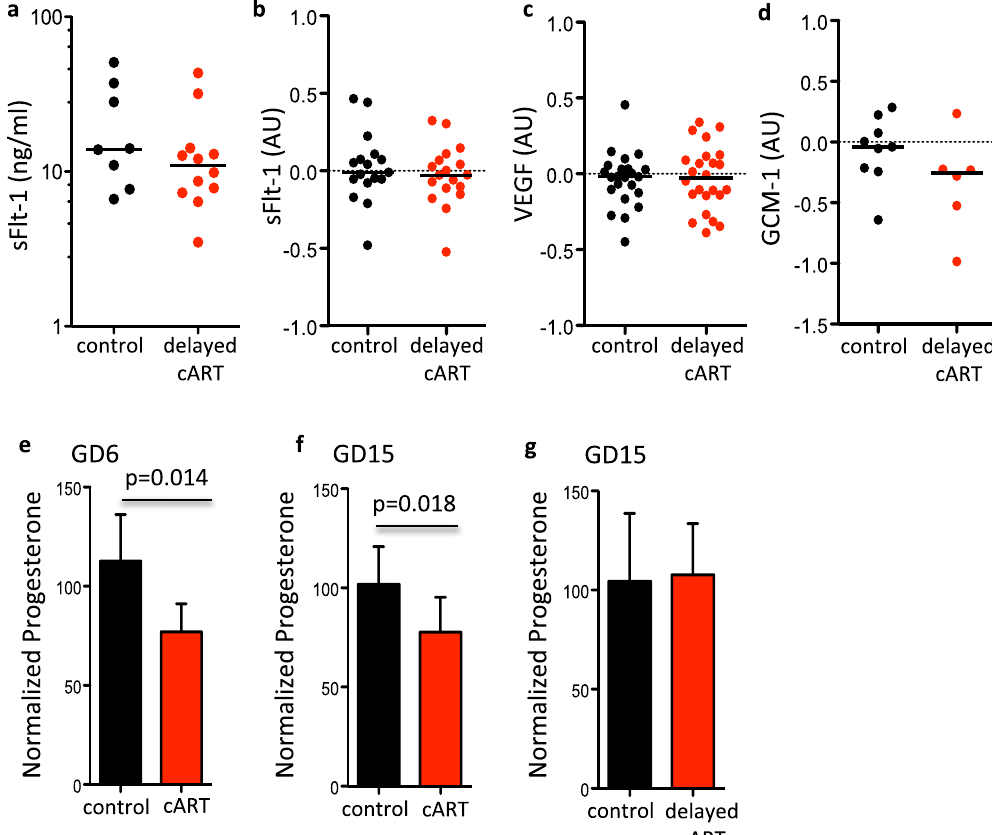
Figure 4. Delaying initiation of cART prevents dysregulation of sFlt-1 and Gcm-1, and progesterone declines. Pregnant mice were treated by gavage with cART (zidovudine/lamivudine/lopinavir/ritonavir) or water as a control starting on GD6 (delayed cART) until sacrifice on GD15. Peripheral levels of sFlt-1 ( a ) were assessed by EIA in serum collected at GD15 from control (black, n = 8) and cART-treated (red, n = 12) pregnant mice. Placental expression levels (log transformed) of sFlt-1 ( b ), Vegf ( c ), and Gcm-1 ( d ) were assessed by qPCR in placentas from control (black) and cART-treated (red) mice collected at GD15. For ( b ) n = 17 placentas from 7 dams for control and n = 18 placentas from 9 dams for cART, for ( c ) n = 23 placentas from 7 dams for control and n = 24 placentas from 9 dams for cART, and for ( d ) n = 9 placentas from 3 dams for control and n = 6 placentas from 3 dams for cART. Statistical comparisons by Mann Whitney U test. Peripheral progesterone levels at GD6 ( e ) or GD15 ( f ) in pregnant mice exposed to control (black), cART starting on GD1 (red), and peripheral progesterone levels at GD15 in pregnant mice exposed to control (black) or cART starting on GD6 (red, delayed cART) ( g ). Data are shown as means with standard deviation. Statistical comparisons by Student’s t-test. For ( e ) and ( f ) n = 10 dams for control and n = 7 dams for cART. For ( g ) n = 7 dams for control and n = 5 dams for delayed